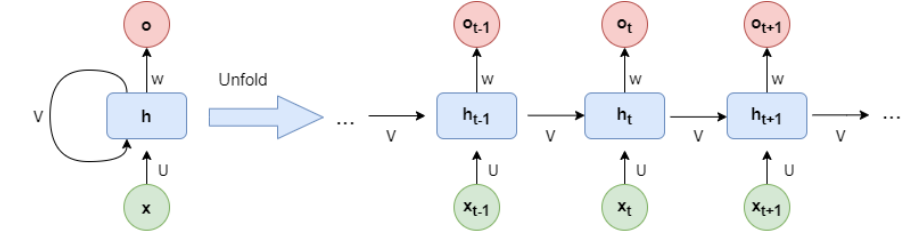
Figure 2. Illustration of RNN(Redrawn from